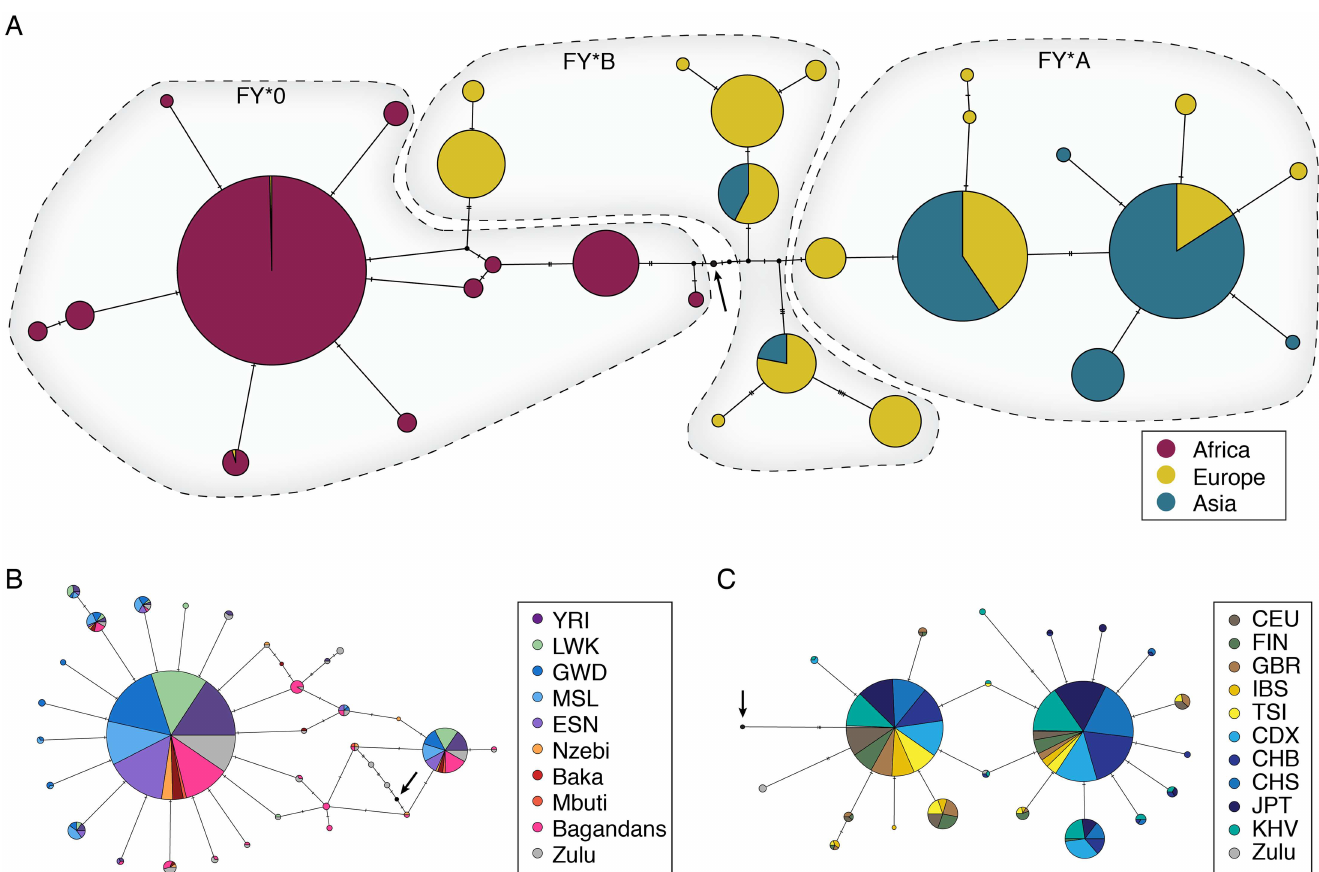
Fig 2. Haplotype networks. Median joiningnetworks of three subsets of haplotypes in the 5kb regioncentered on the FY * O mutation. The FY * A mutation is located671 bps downstreamfrom the FY * O mutation. Arrows indicatesancestralsequence.A) All haplotypesobserved at least four times B) All FY * O haplotypes observedat least twice. (Note that none of the FY * O haplotypes in this network also carry the FY * A mutation.) C) All FY * A haplotypes observedat least twice. (Note that none of the FY * A hapotypesin this network also includethe FY * O